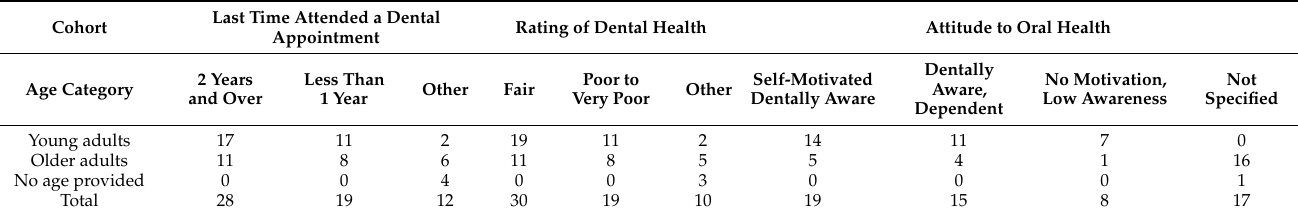
Table 3. Participants’ access to dental services, self-assessment of their current oral health and attitude evaluation to maintaining good oral